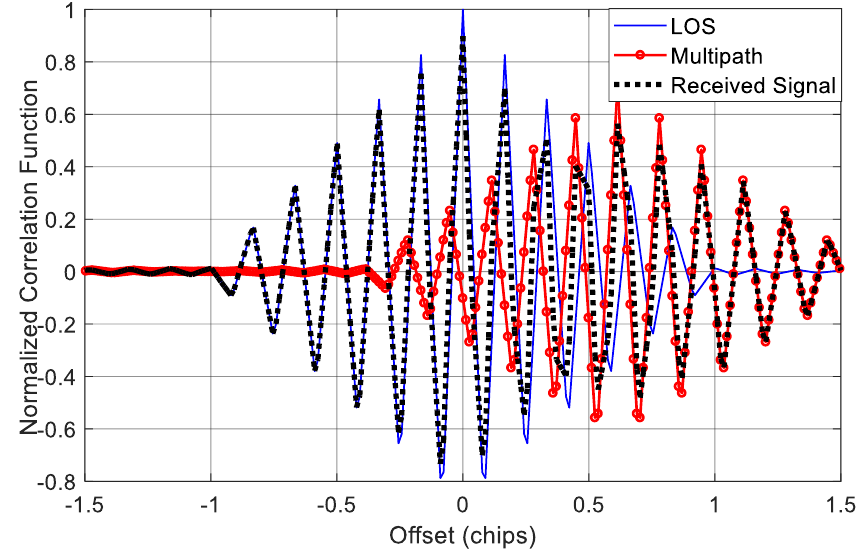
Figure 16. Correlation function of BOC(15,2.5) signal in the presence of single multipath component.